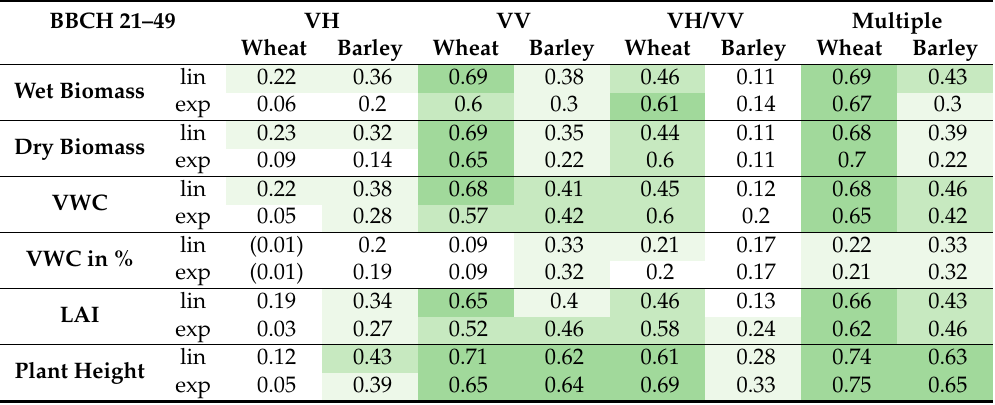
Table 4. R 2 values of the regression between crop and backscatter parameters per crop type for